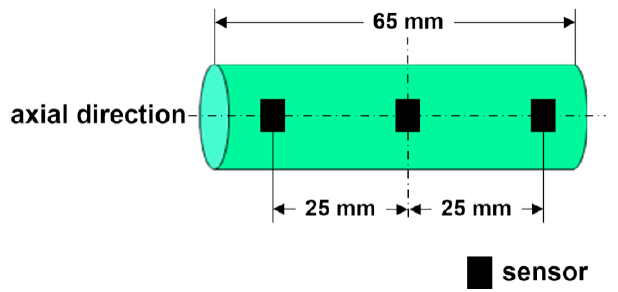
Figure 1. Positions of temperature sensor attachments.